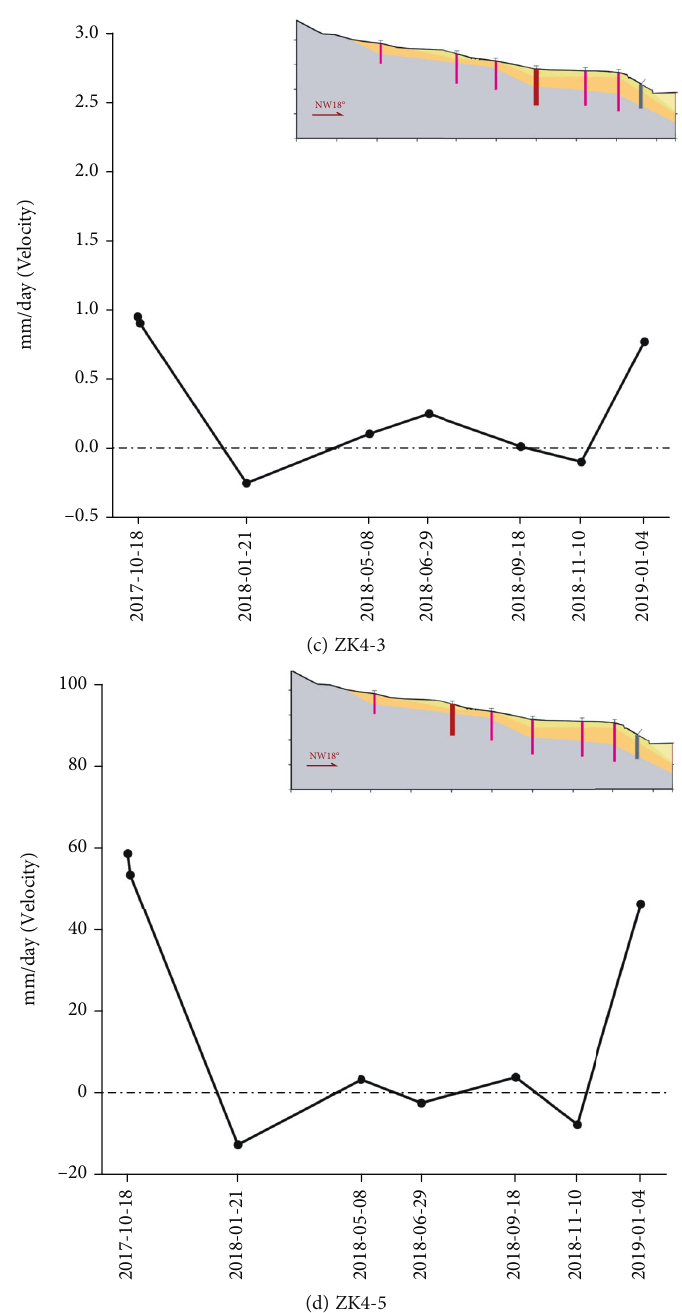
Figure 16: Displacement rate at 0.5m depth of ZK4-1, ZK4-2, ZK4-3, and ZK4-5